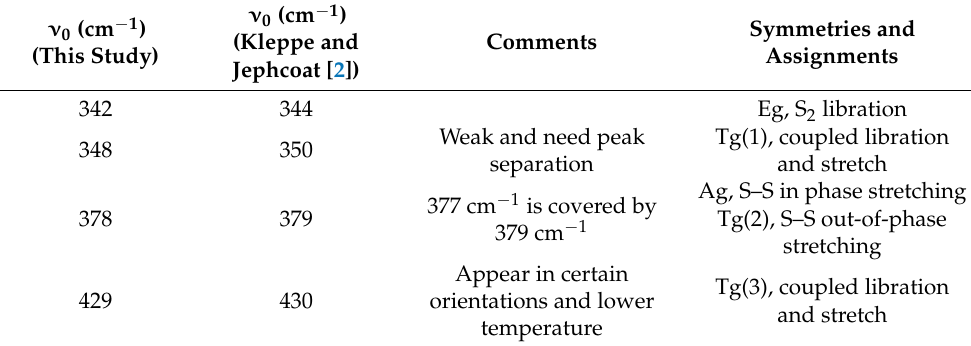
Table 2. Ambient Raman bands (cm − 1 ) of pyrite at 298 K.